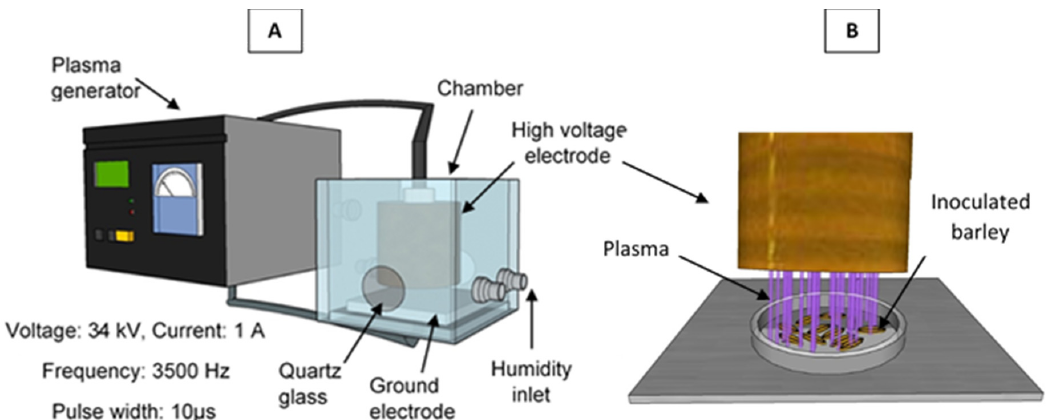
Figure 1. ( A ): Schematic diagram of the experimental setup used for dielectric barrier discharge (DBD) atmospheric cold plasma (ACP) treatment. ( B ): Close-up diagram presenting the treatment of barley grains inside the ACP chamber.